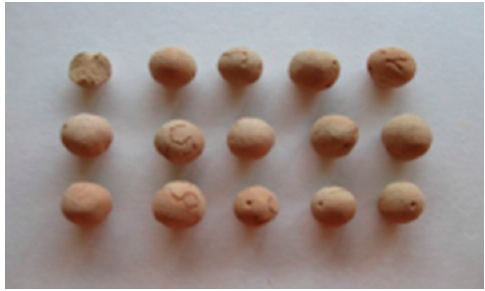
Figure 3. Sintered Materials.